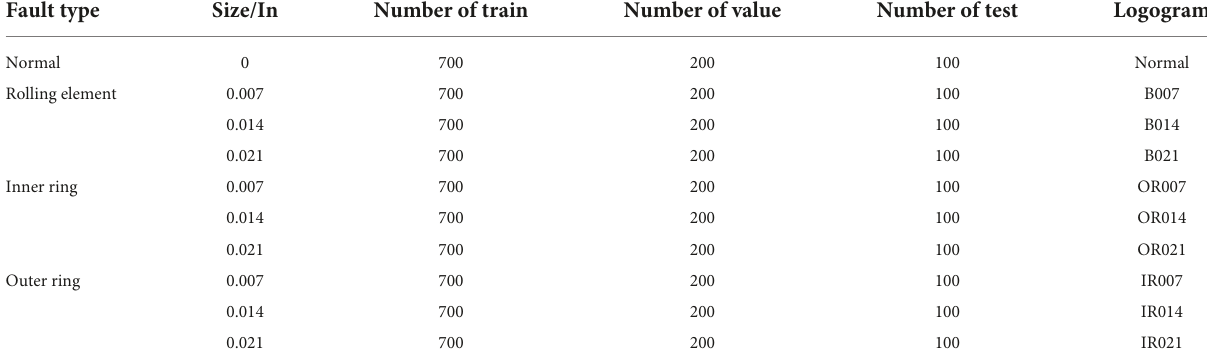
TABLE 2 Dataset